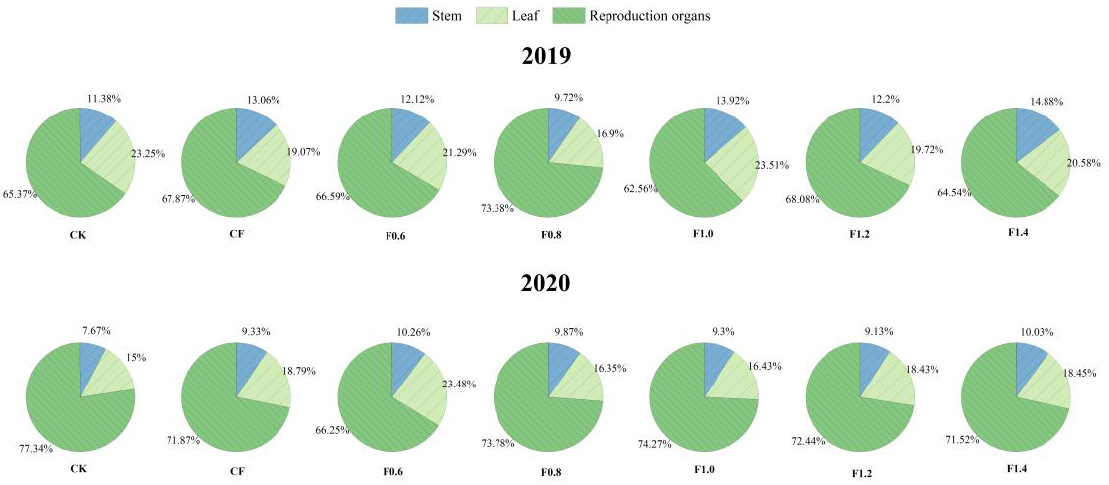
Figure 4. Distribution of N in different organs under different fertilization patterns during harvest.